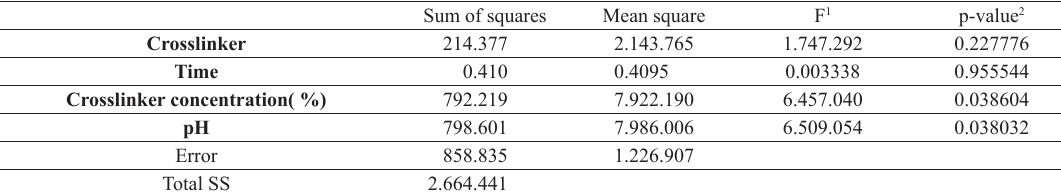
Table 2. Analysis of variance for a 2 4,1 factorial experimental design.